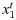
Cofluctuations of time series as a basis for stimulus discrimination.A: Three types of correlations for two time series (in light and dark brown). Signal correlations (left column) measure the similarity of individual trajectories across trials up to some additional noise. Importantly, the light and dark time series may be uncorrelated within each trial. Conversely, within-trial correlations (middle columns) correspond to the situation where trials may be distinct, but the two time series within a trial are correlated (positively here, the left configuration with zero lag and the right configuration with a lag of 3 for visual legibility). This is the subject of the present study. Last, noise correlations (right column) concern the means of the time series, as represented by the dashed lines, that are either both positive or both negative within each trial. B: For the discrimination of multivariate time series, as in panel A, we here consider two categories (red and blue). The time series x1t and x2t, displayed in the (x1, x2)-plane in the left plot, show one example for each category. From each category example, one can calculate the mean (here a vector of dimension 2), corresponding to a single dot in the right plot. Learning for classification aims to find a separatrix between the red and the blue point clouds. The presence of noise correlations between the means affects the overlap between the dot groups (e.g. positive for the shown example), hence the classification performance. Alternatively, one can compute from the same time series their (within-trial) variances and covariances, yielding points in a three-dimensional space here (middle plot, where v1 and v2 are the respective variances, and c12 the cross-covariance). Here classification is based on the within-trial covariances as features to learn, which conceptually differs from the mean-based learning and noise correlations in the right panel.